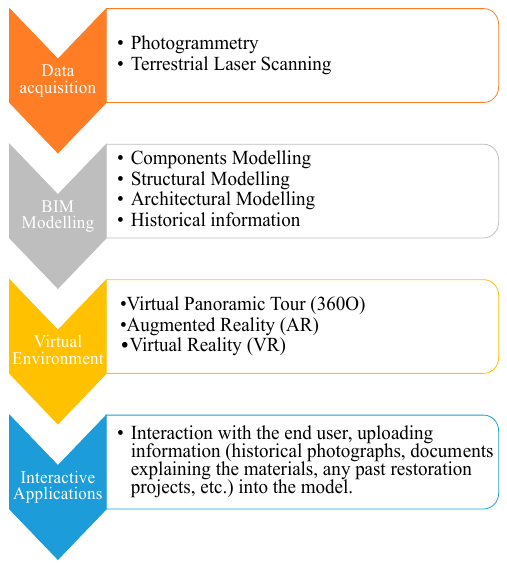
Figure 6. Outline of the method.